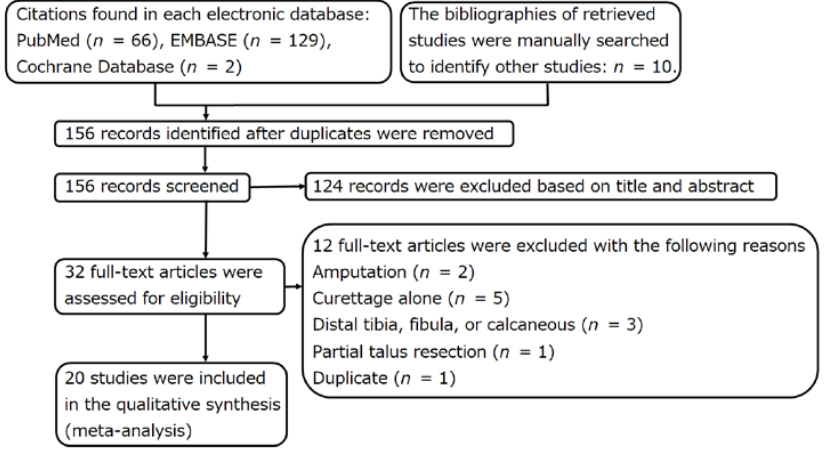
Figure 1. Flow chart of the search for relevant articles.